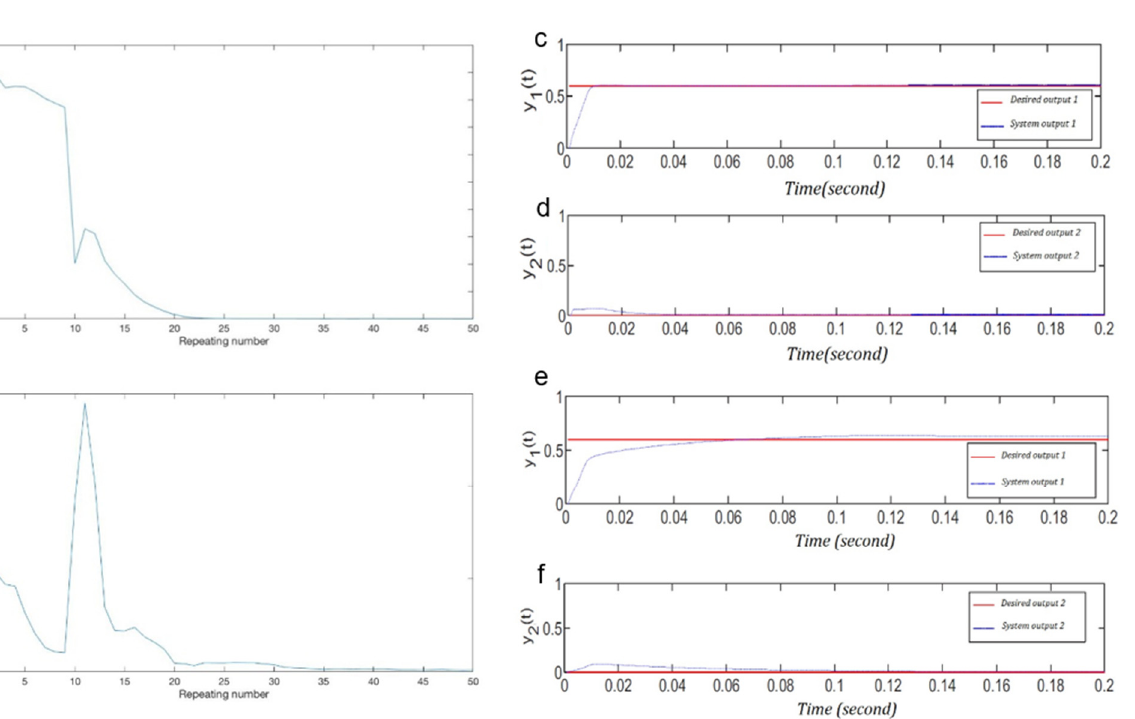
Figure 3. ( a ) Case 1: error value for Output 1 versus the repeating number and ( b ) case 1: error value for Output 2 versus the repeating number; ( c ) case 2: Output 1 and desired Output 1 by MANNC, ( d ) case 2: Output 2 and desired Output 2 by MANNC, ( e ) case 2: Output 1 and desired Output 1 by PIDNN, and ( f ) case 2: Output 2 and desired Output 2 by PIDNN.